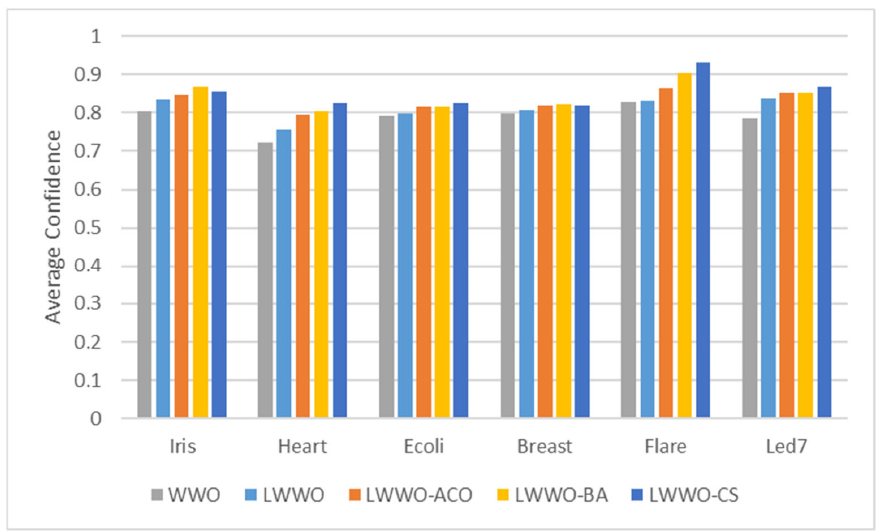
Figure 8. Comparison of average confidence.